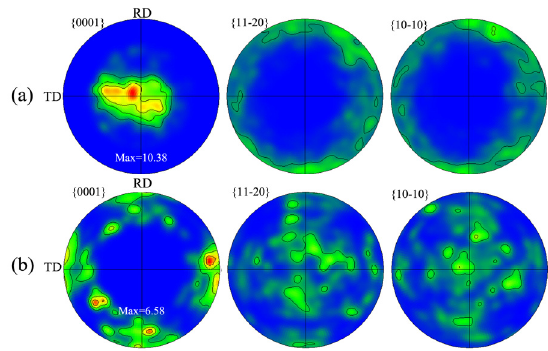
Figure 5. The {0001} pole figures of ( a ) parent grains and ( b ) {10–12} twins in the WB sample.